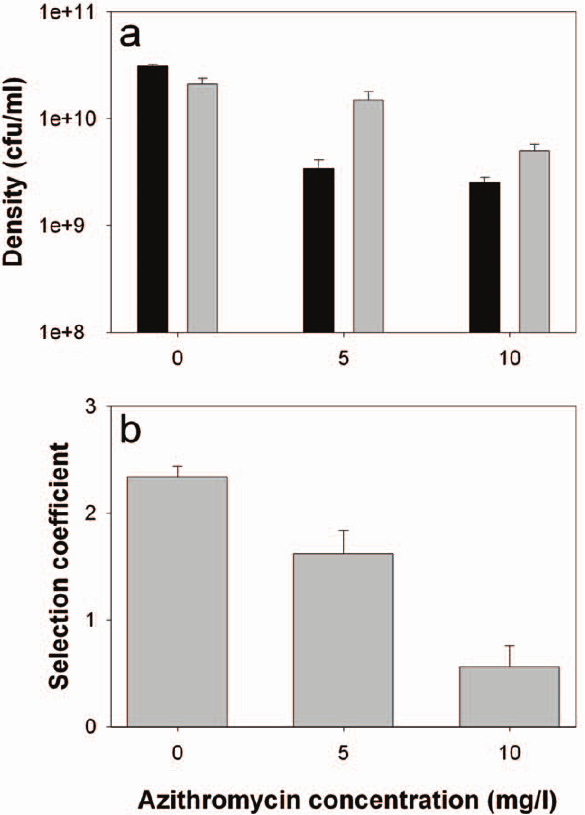
Figure 3. Evolution of lasR mutants and elastase production in azithromycin-treated and untreated patients. Change in the proportion of lasR mutants (a) and mean elastase production (b) through time. Solid lines and closed symbols indicate azithromycin- treated patients, and dashed lines and open symbols indicate placebo group. Note that data is presented to day 11 of colonization, despite some samples being collected up to 20 days, because of very small sample sizes (six isolates) by day 12 in the azithromycin-treated group. However, qualitatively identical results were obtained when the whole data set was analysed. The change in the proportion of lasR mutants and elastase through time was analysed using logistic regression, corrected for under-dispersion, and General linear Modelling, respec- tively in GenStat 10.